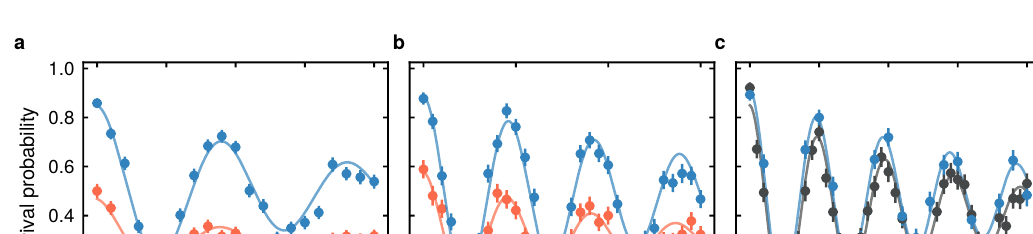
Figure 5: Resonant Rabi oscillations between the ground F = 2, m = − 1 / 2 states, averaged over five tweezers. Oscillations with Rydberg 62 P , m J 1 / 2 (blue) and without (red) Raman sideband cooling and fit of an exponentially damped oscillation for Rabi frequencies of a. 2 π · 100kHz and b. 2 π · 200kHz. c. Rabi oscillations of 2 π · 400kHz with (blue) and without (black) switching off the trap. Both measurements were performed with Raman cooling and ramping the trap to 5